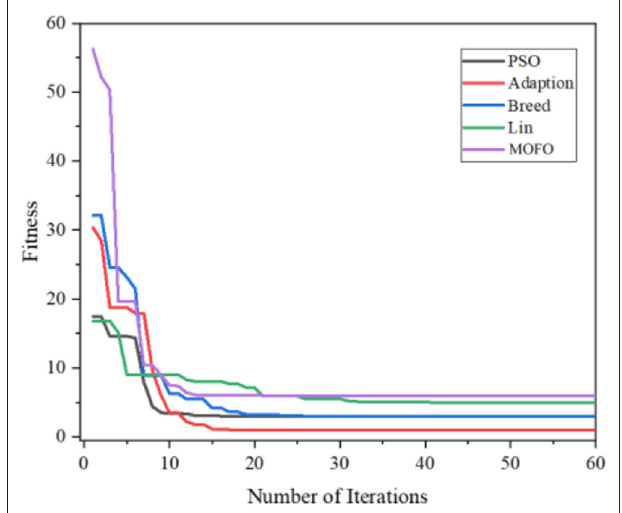
FIGURE 4 | The comparison of the convergence speed of different algorithms.